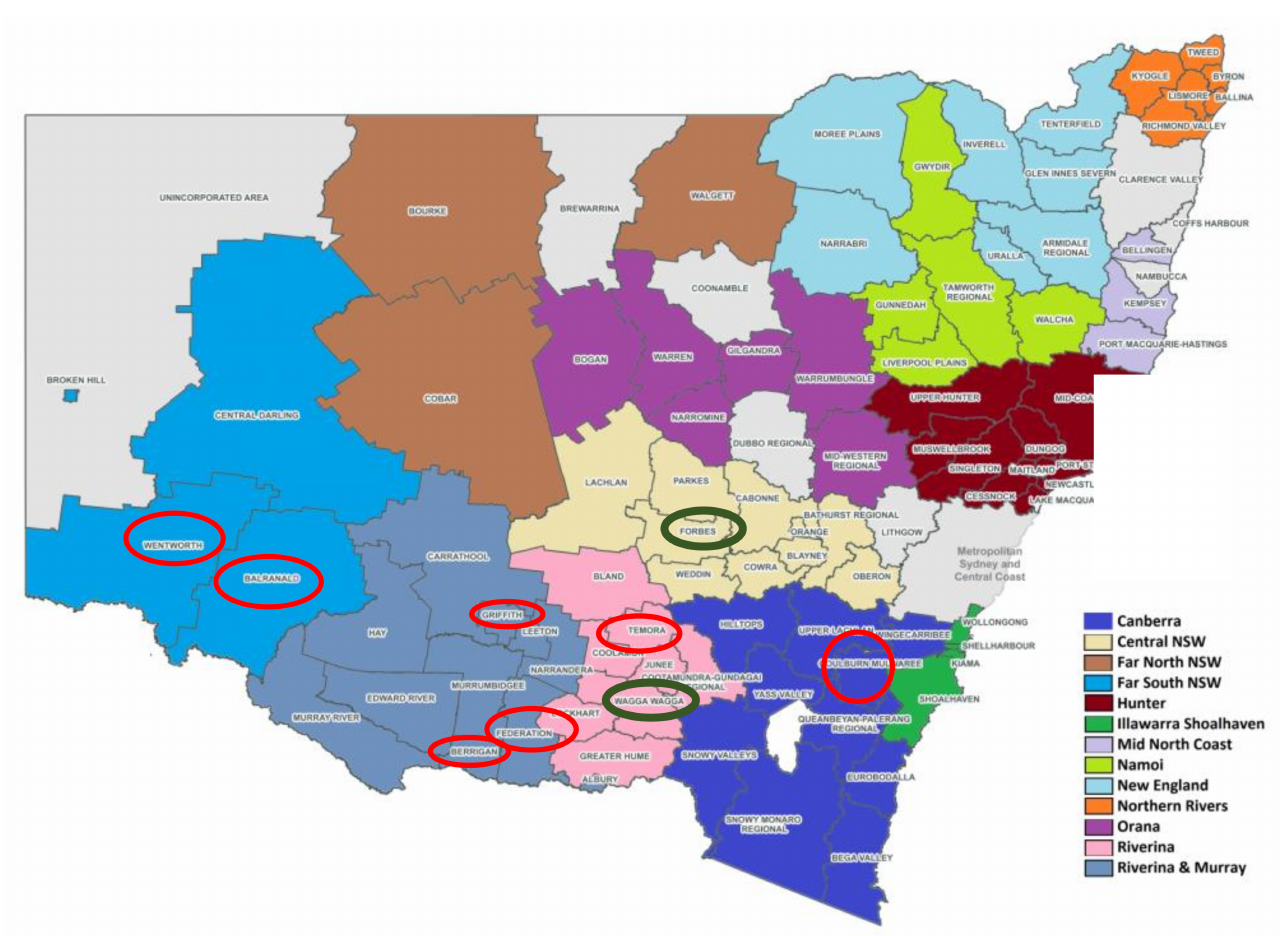
Figure 1. LGAs* with confirmed human cases circled in red and positive mosquito popula- tions circled in green. (*Map modified from Joint Organisations—Office of Local Government NSW (https://www.olg.nsw.gov.au/programs-and-initiatives/joint-organisations/#:~:text=NSW%2 0boasts%20a%20network%20of,service%20delivery%20to%20regional%20communities, accessed on 27 June